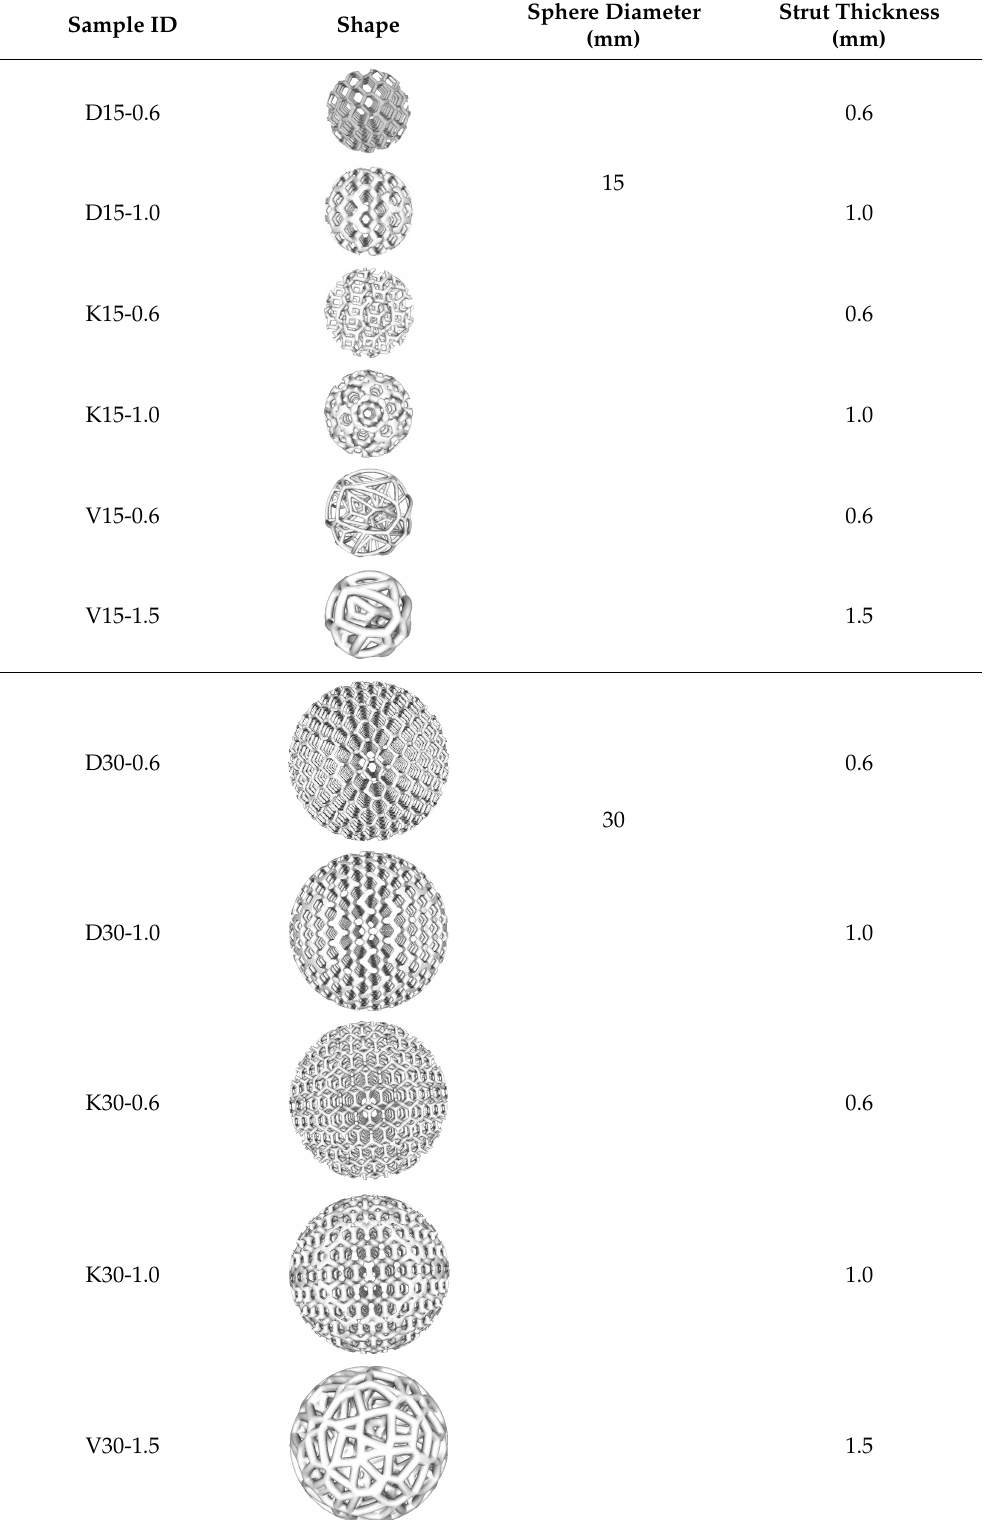
Table 4. Geometrical characteristics of the PA 12 beads produced by PBF.